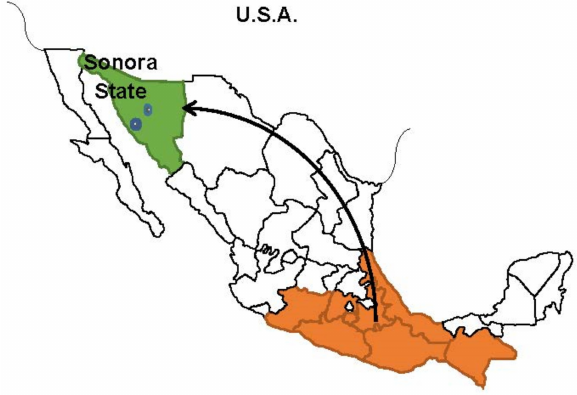
Figure 1. Regions of attraction and origin of migrant farm workers in